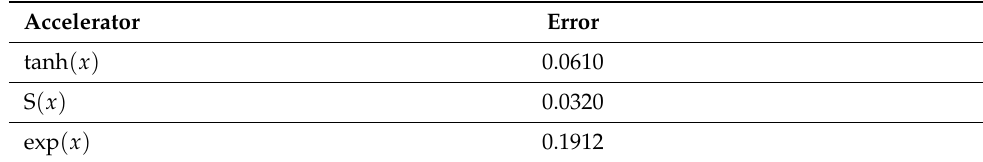
Table 4. Maximum absolute error in the x-range of x mathematical function.